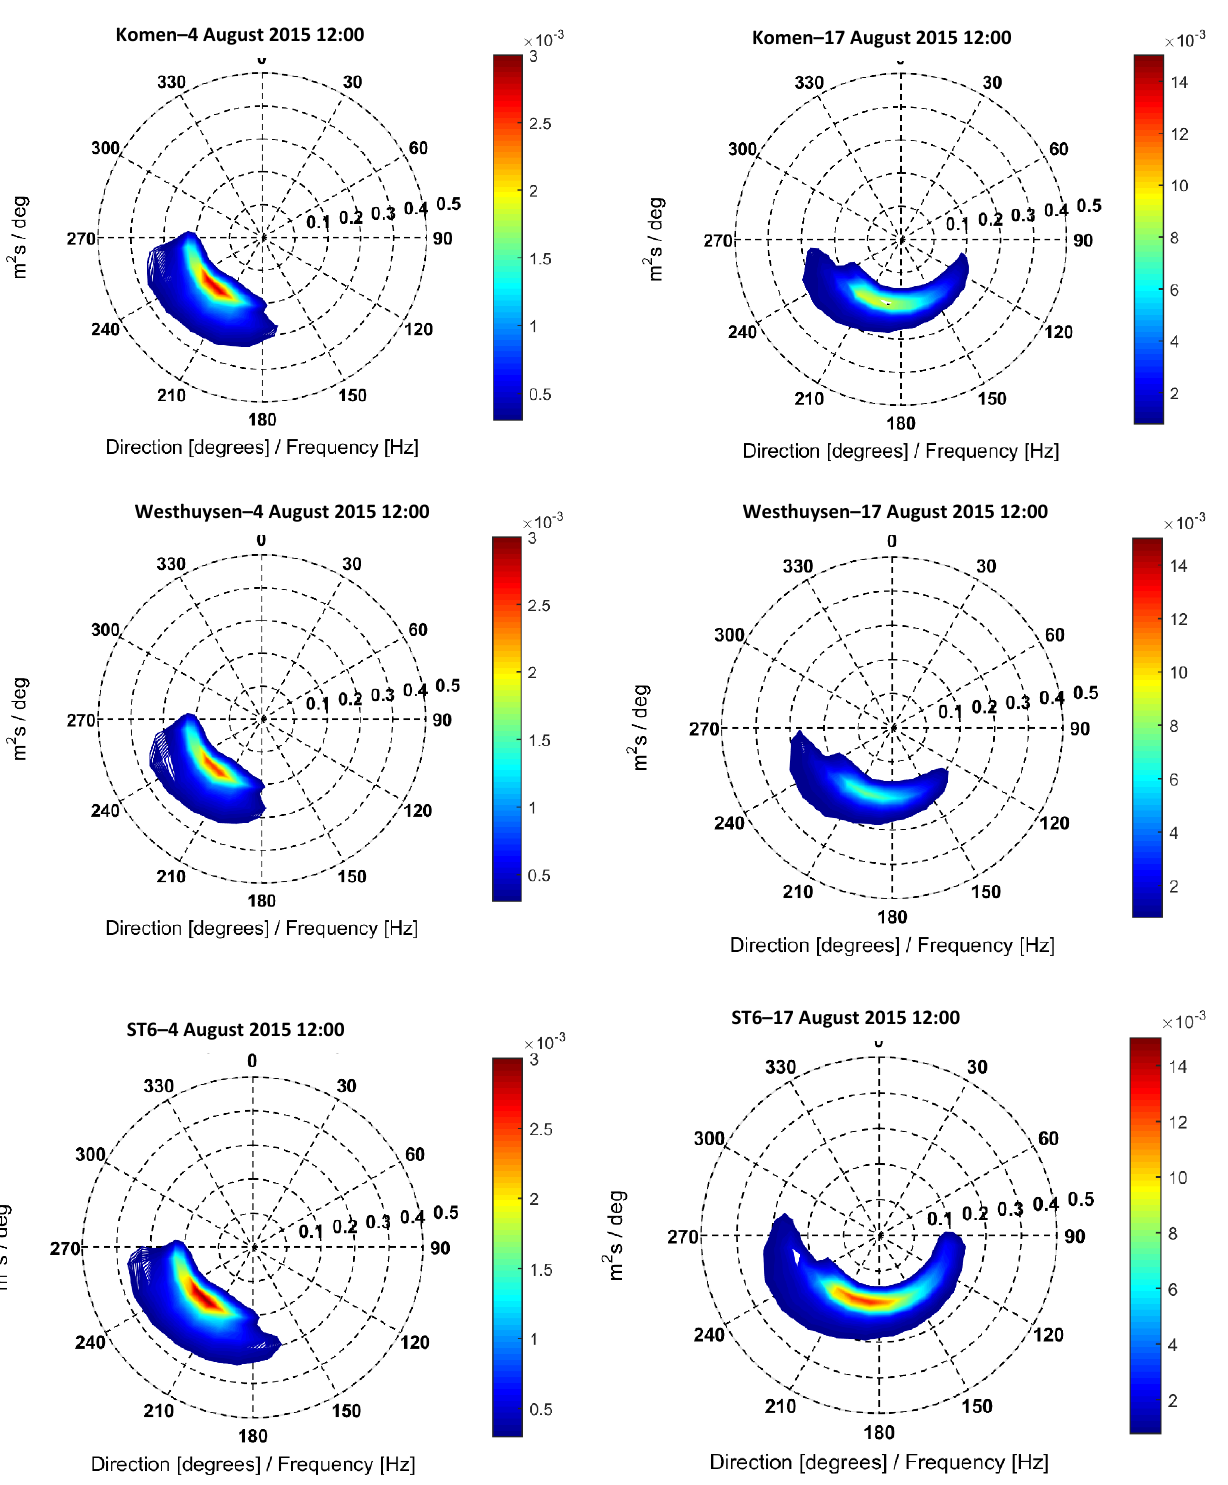
Figure 12. Simulated frequency-direction spectra by different whitecapping formulations at LOPL1 at (left panel) time t 1 and (right panel) time t 2